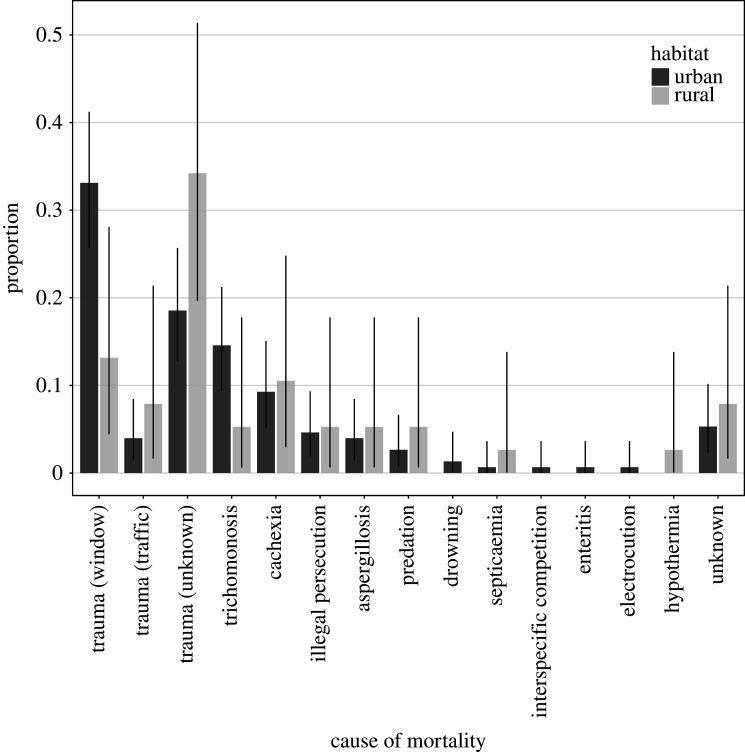
Proportion (with CI95%) of causes of mortality at urban and rural locations.